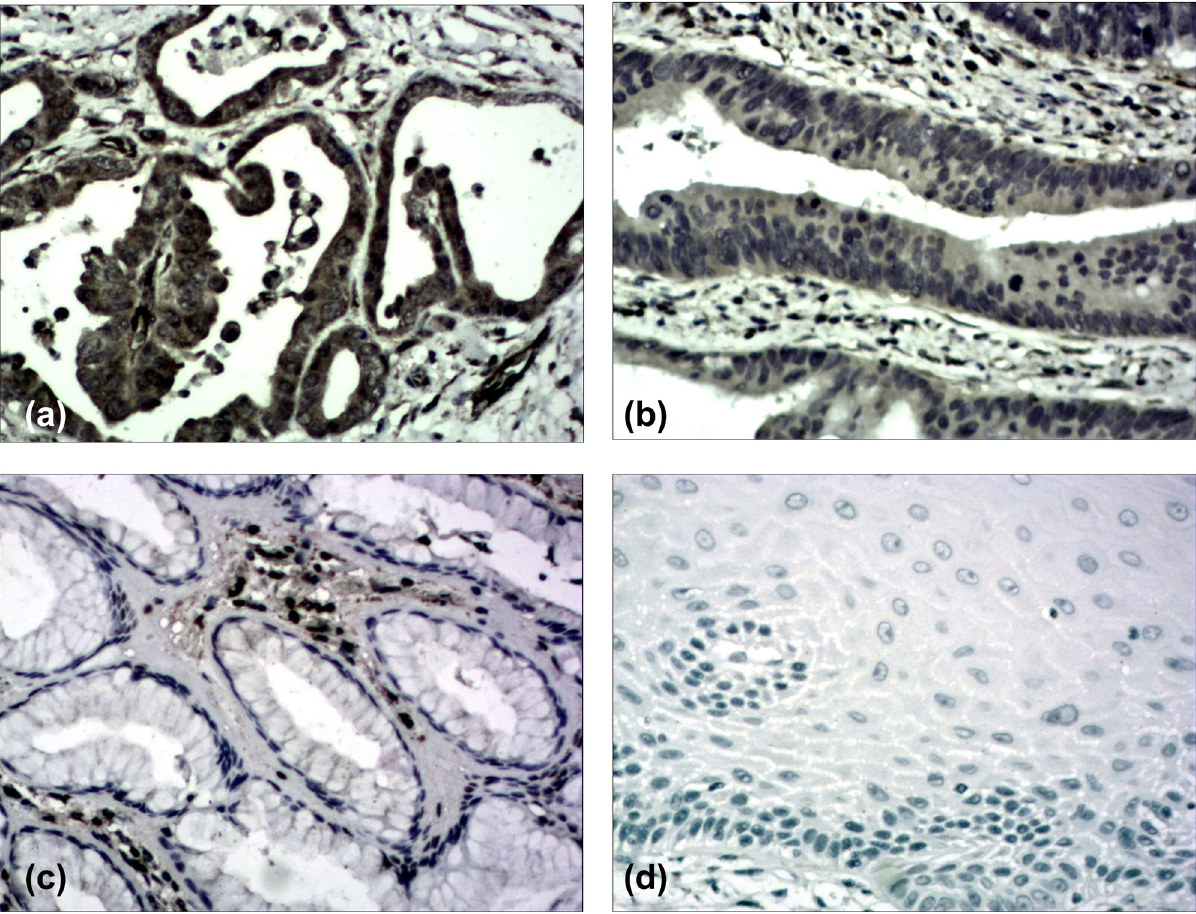
Figure 1: Immunohistochemical staining of adenocarcinoma of the esophagogastric junction ( AEG ) tissue sections demonstrating Matrix metalloproteinase - 2 ( MMP - 2 ) ( Original magni fi cation × 200 ) . ( a ) AEG specimen with high expression of MMP - 2. ( b ) AEG specimen with low expression of MMP - 2. ( c ) The corresponding normal gastric tissue specimen with no MMP - 2 expression ( contrast ) . ( d ) The corresponding normal esophageal tissue specimen with no MMP - 2 expression ( contrast )